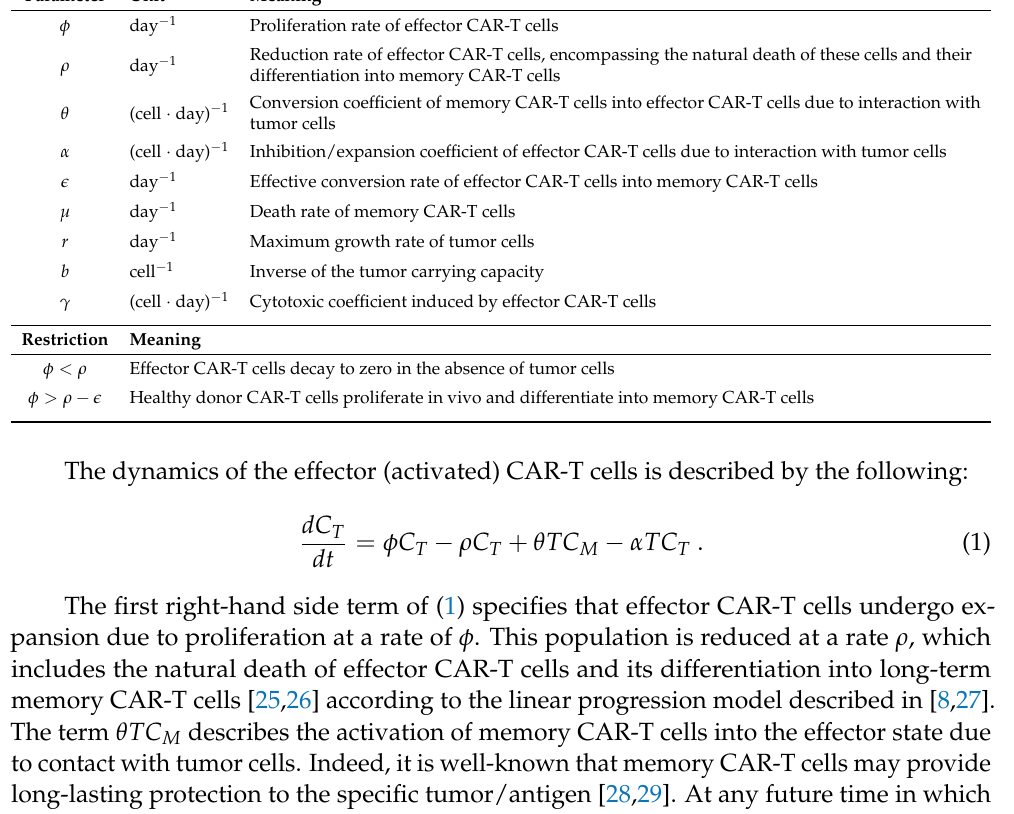
Figure 1. Schematic description of the model structure. Effector CAR-T cells proliferate, have a cytotoxic effect on tumor cells, differentiate into memory CAR-T cells, and die naturally or are impaired by tumor-induced immunosuppressive mechanisms. The long-term memory CAR-T cells also die naturally and are readily responsive to the tumor-associated antigen, and when they interact with tumor cells, they differentiate back into effector CAR-T cells, producing a rapid immune response against the tumor. Tumor cells grow subject to available resources in the microenvironment and are killed by effector CAR-T cells. Table 1. Model parameters and the two restrictions imposed on φ , ρ , and (cid:101) . Parameter